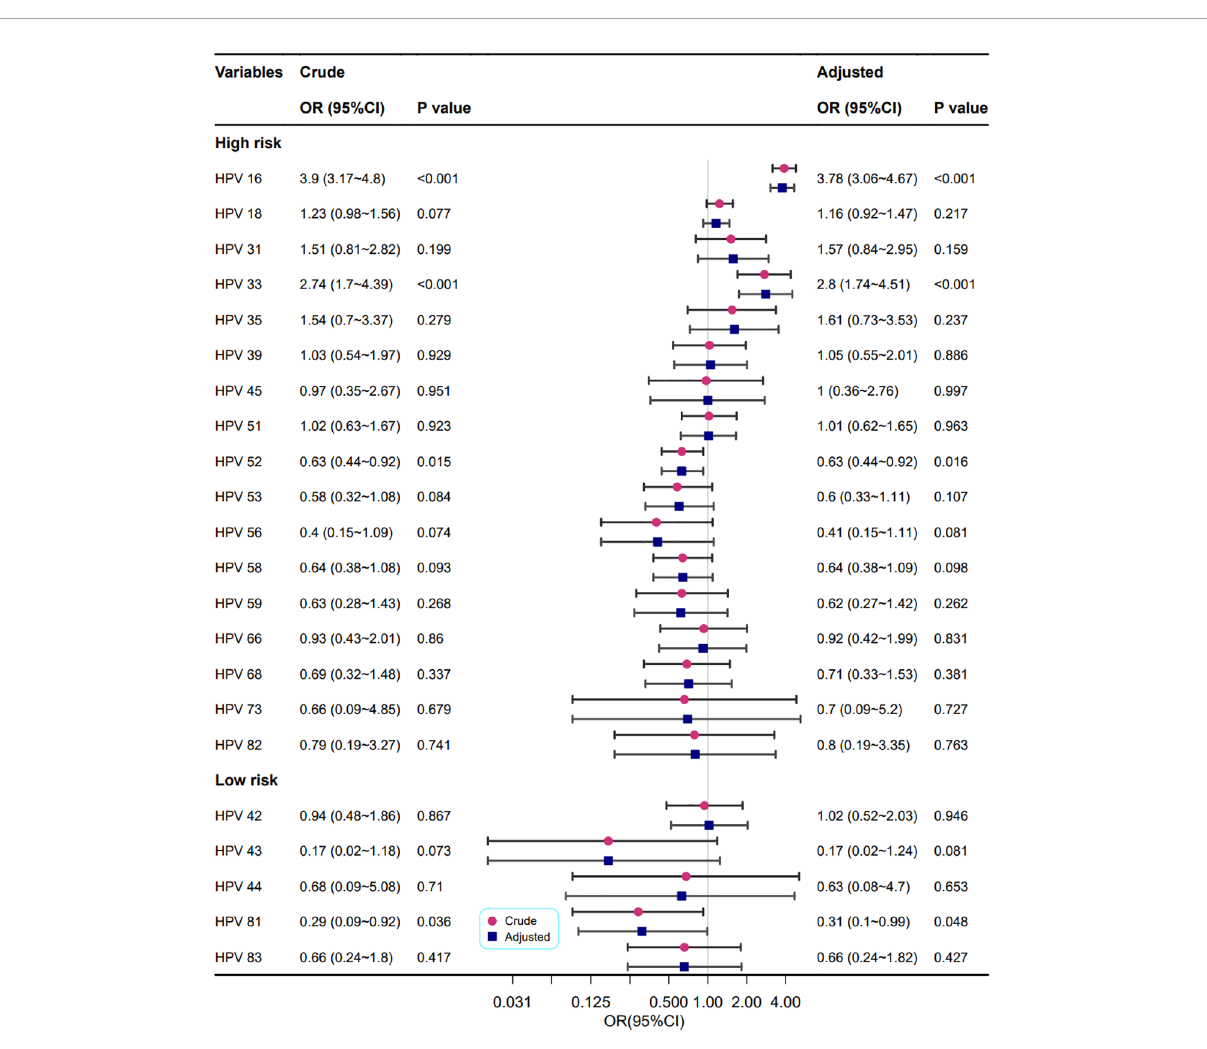
FIGURE 4 Association between different HPV genotypes and punctate vascular features. Model adjustments for age, gravidity, and